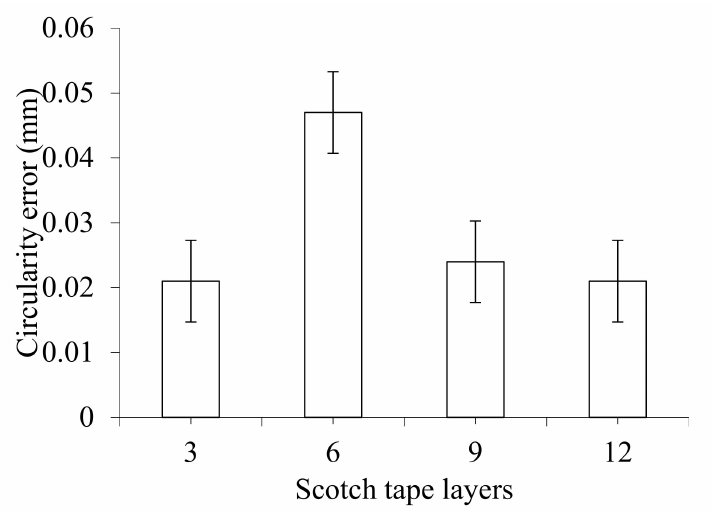
Figure 7. Effect of Scotch tape layer on circularity error at drill bit diameter of 6 mm, point angle of 125 ◦ , spindle speed of 2250 rpm, and feed rate of 0.11